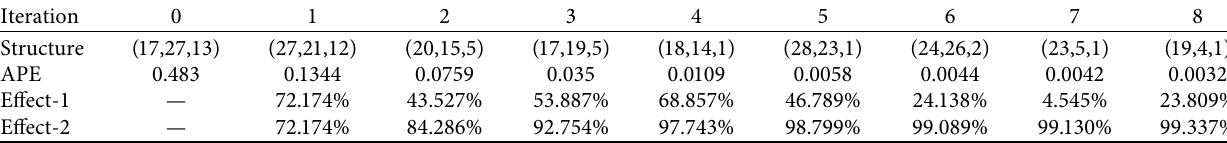
Table 5: MA iteration results on CMSA.